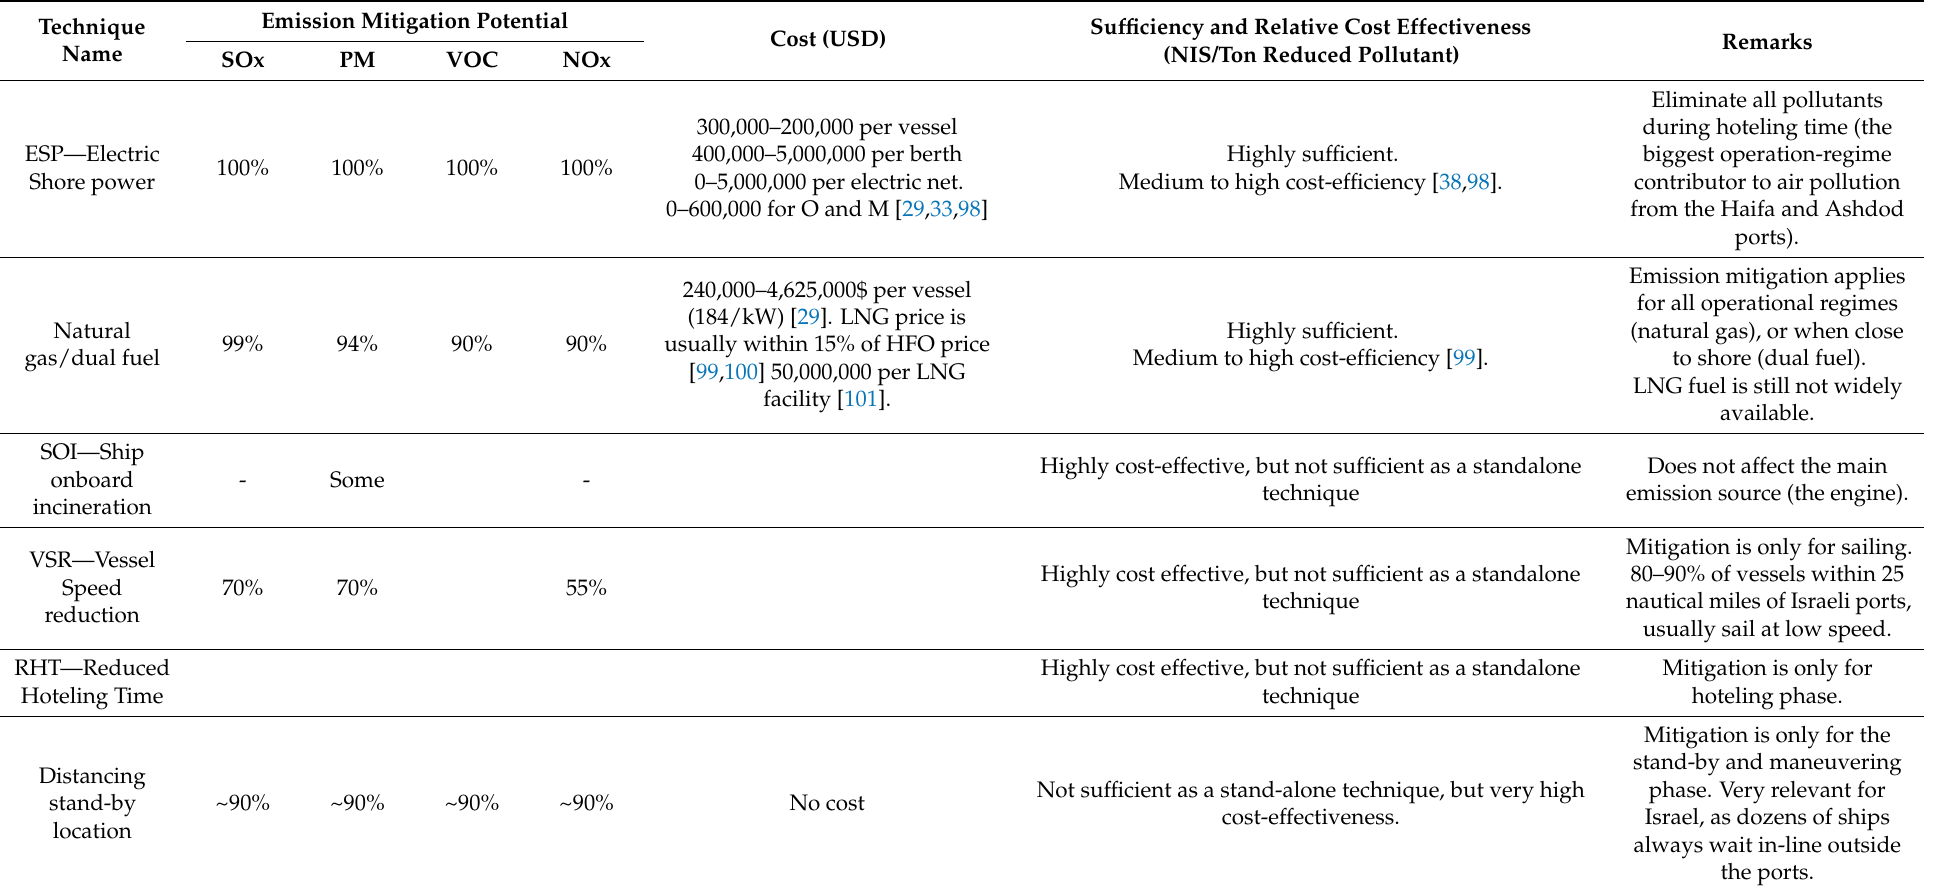
Table A33. Holistic mitigation